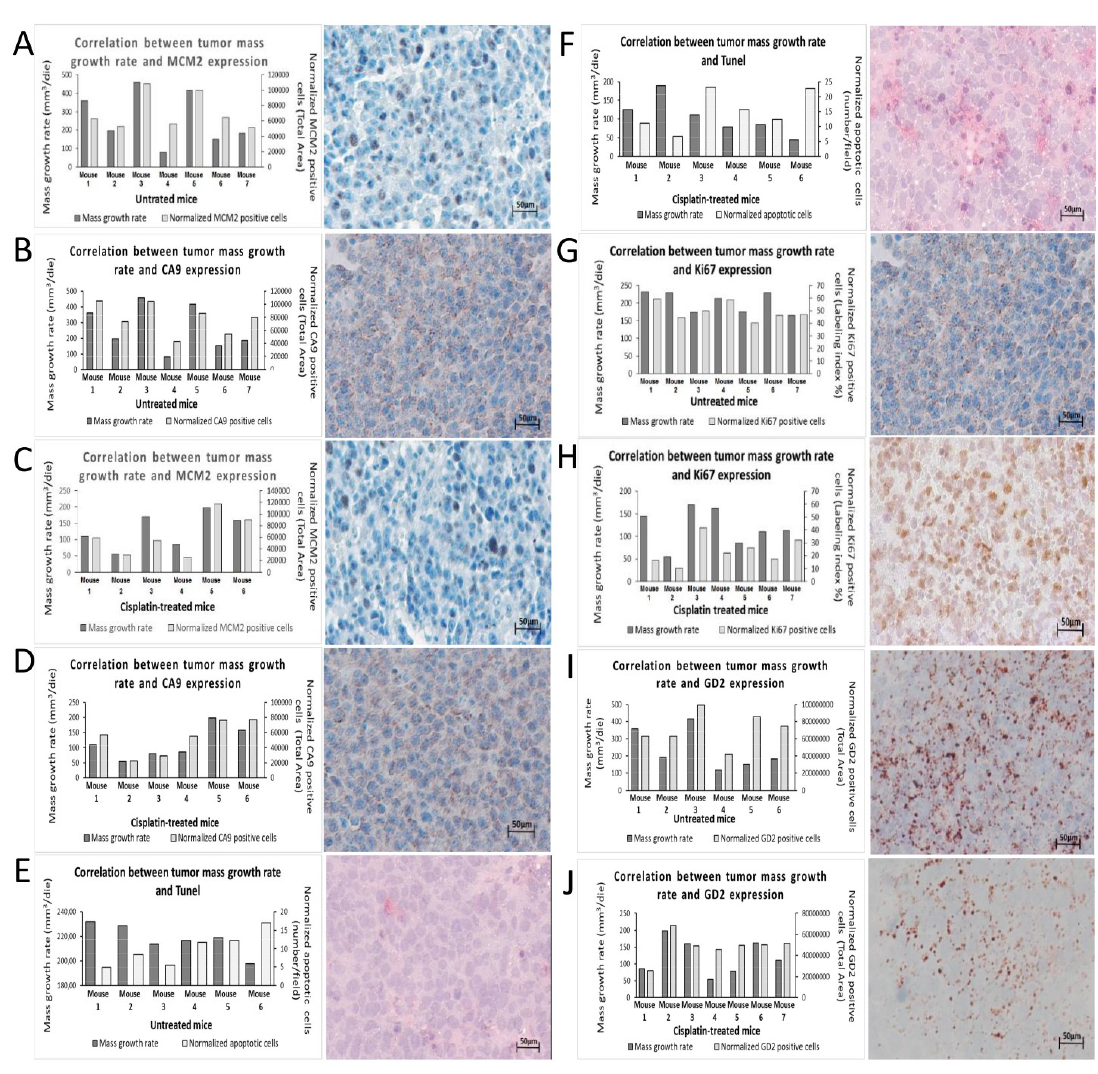
Figure 5. Immunohistochemical analysis of tumor nodule. ( A ) Correlation between tumor masses growth rates and: CA9 in untreated and ( C ) cisplatin-treated mice, ( B ) MCM2 in untreated and ( D ) cisplatin-treated mice. ( E ) Correlation between tumor masses growth rates and apoptosis in untreated and ( F ) cisplatin-treated mice. ( G ) Correlation between tumor masses growth rates and Ki67 in untreated ( H ) and cisplatin-treated mice. ( I ) Correlation between tumor masses growth rates and GD2 in untreated and ( J ) cisplatin-treated mice. The graphs show in left y-axis the growth rate of the tumor masses, expressed as mm 3 / day, and in the right y-axis the positive area of staining calculated by ImageJ software. On the x-axis, the mice involved in the